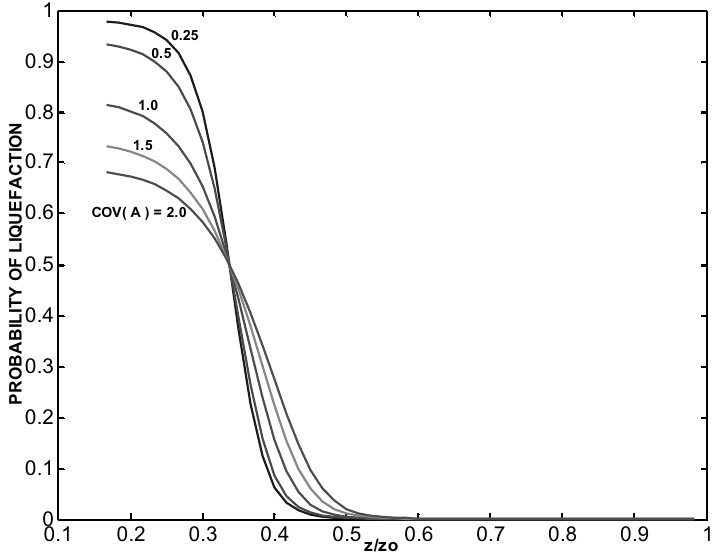
Fig. 6. Variation of the probability of liquefaction with the normalized depth (for several values of the coefficient of variation of the load magnitude).